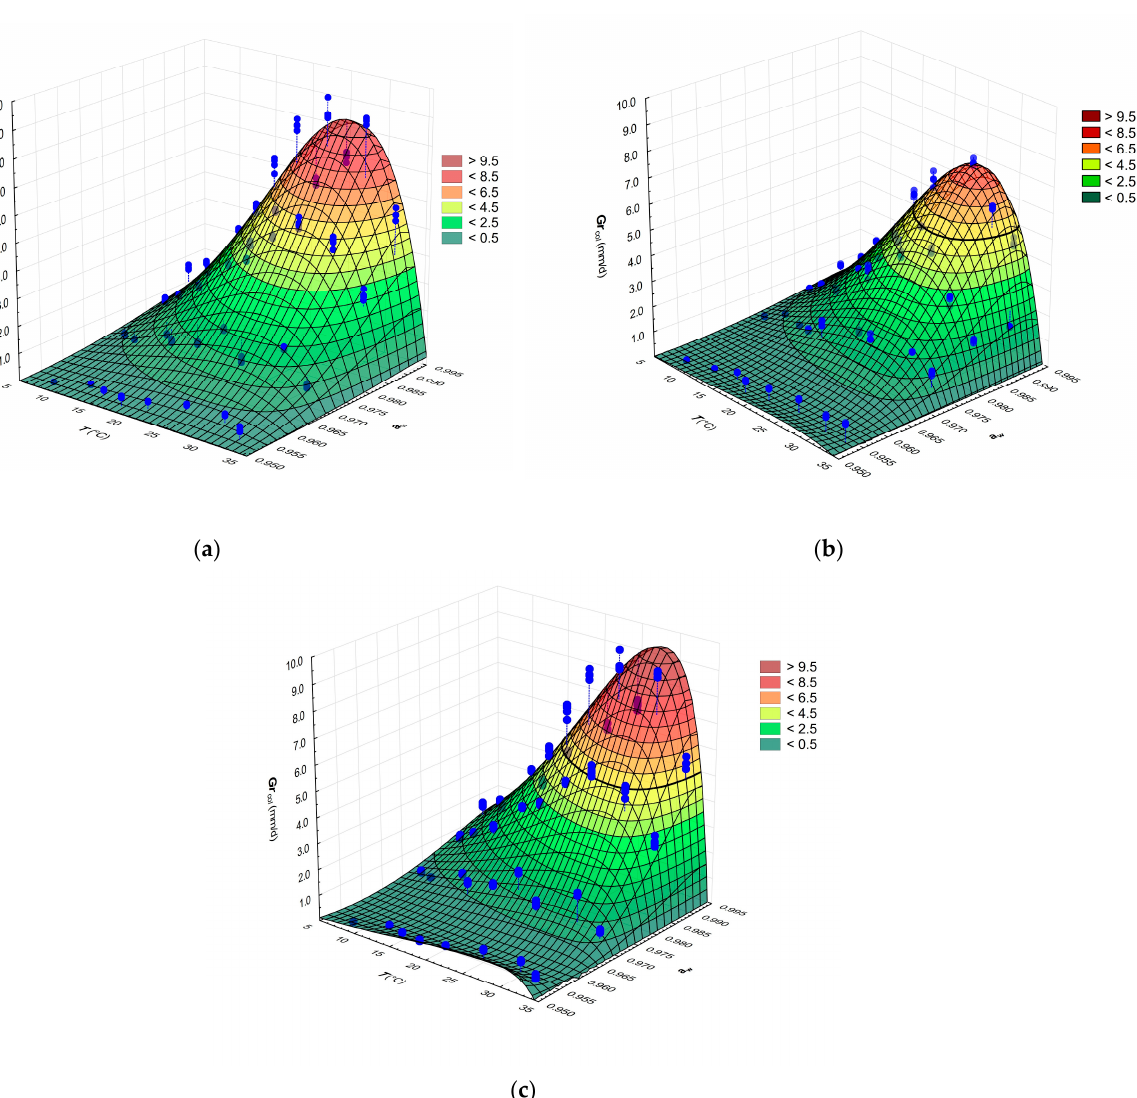
Figure 2. Effects of temperature and a w on the RGR of isolate G ( a ), isolate I ( b ) and collection strain CBS 557.83 of G. candidum ( c ) fitted with CM. Points ( ● ) represent observed values of RGR . The CM parameter values (Table 2) and 3D surface plots indicate that the two G. candidum cheese isolates behaved almost identically. The collection strain CBS 577.83